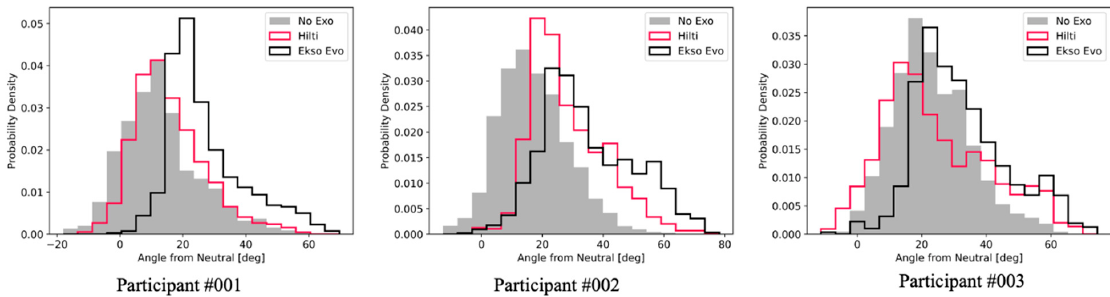
Figure 14. Distribution of the heart rates for individual participants during Task 1. Figure 15. Distribution of the heart rates for individual participants during Task 2.